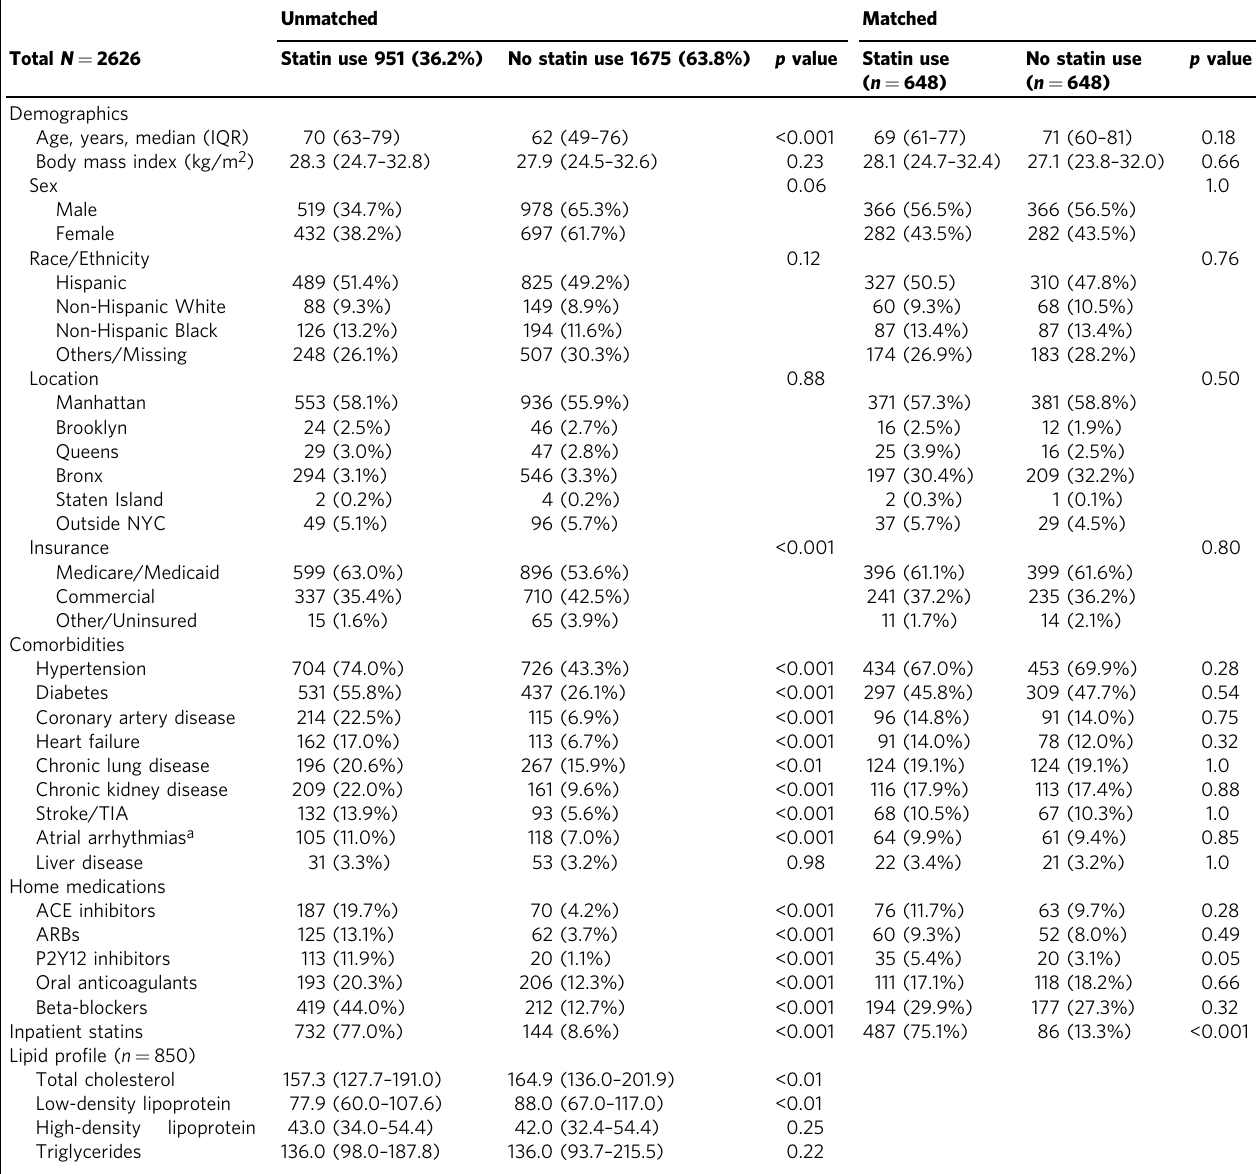
Table 1 Baseline Characteristics in Unmatched and Propensity-Matched Cohorts of Patients Hospitalized with COVID-19. Unmatched